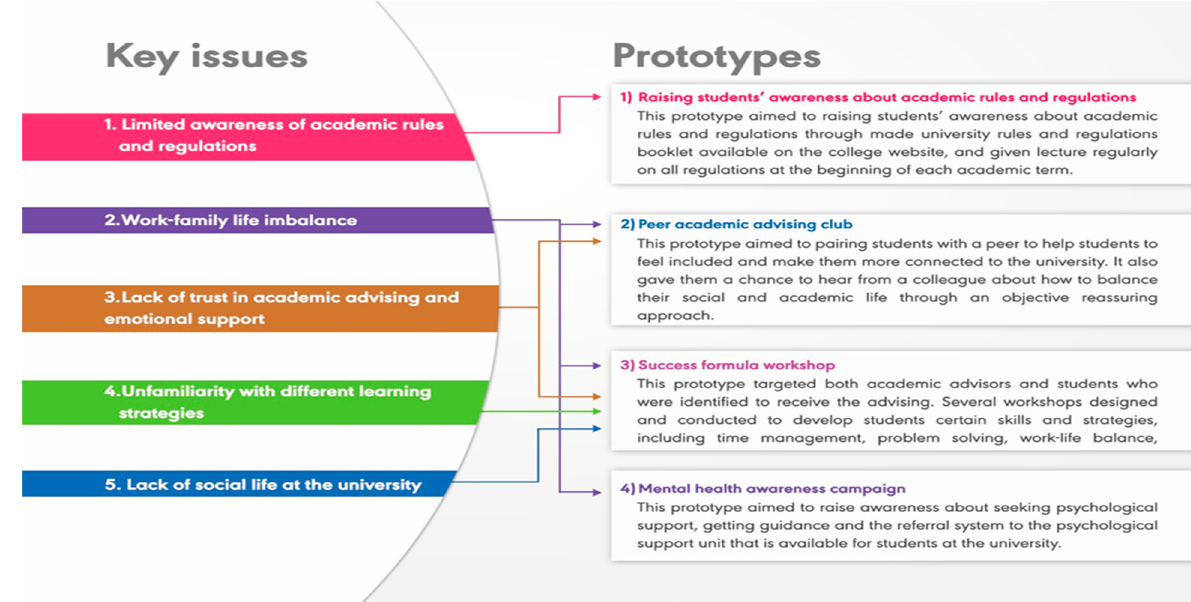
Figure 2. Identified key issues and suggested prototypes.